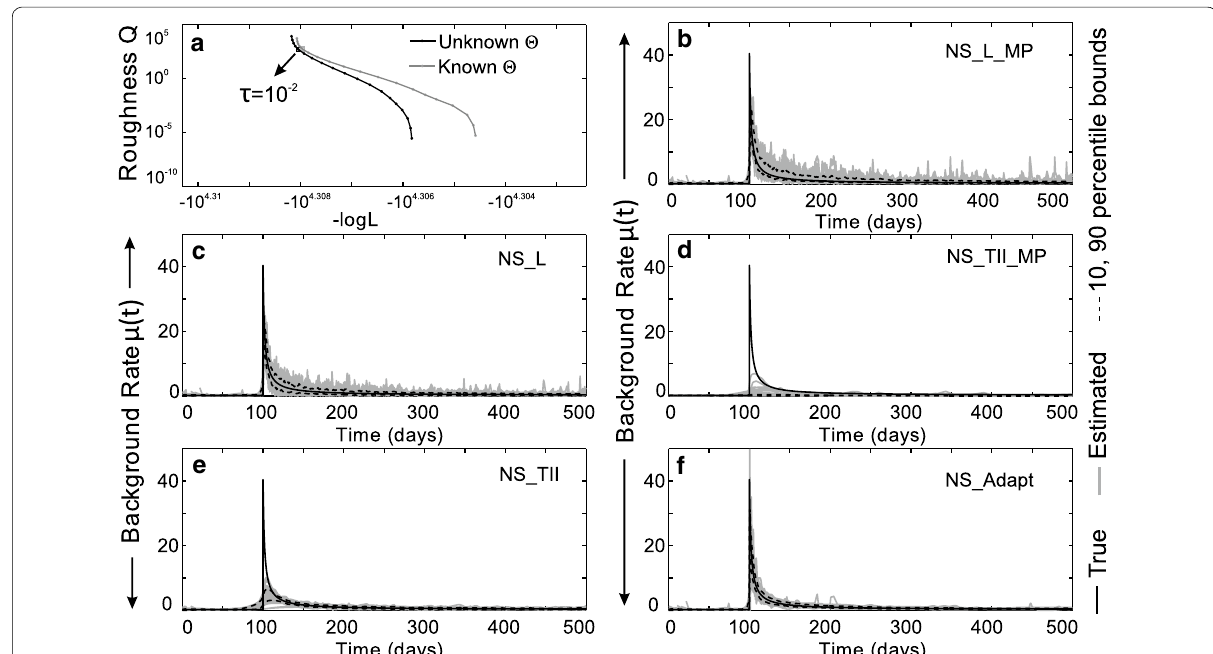
Fig. 2 Results for the synthetic datasets simulated with a Omori’s law-type background rate function. The L-curves computed for one typical syn- thetic dataset along with the point corresponding to the chosen optimal smoothness parameter are shown in ( a ). The estimated background rate function for all 100 synthetic catalogs for each type of model listed in Table 1 is presented in ( b – f ). The true background rate function and the 10, 90 percentile bounds of estimates for each model are also shown